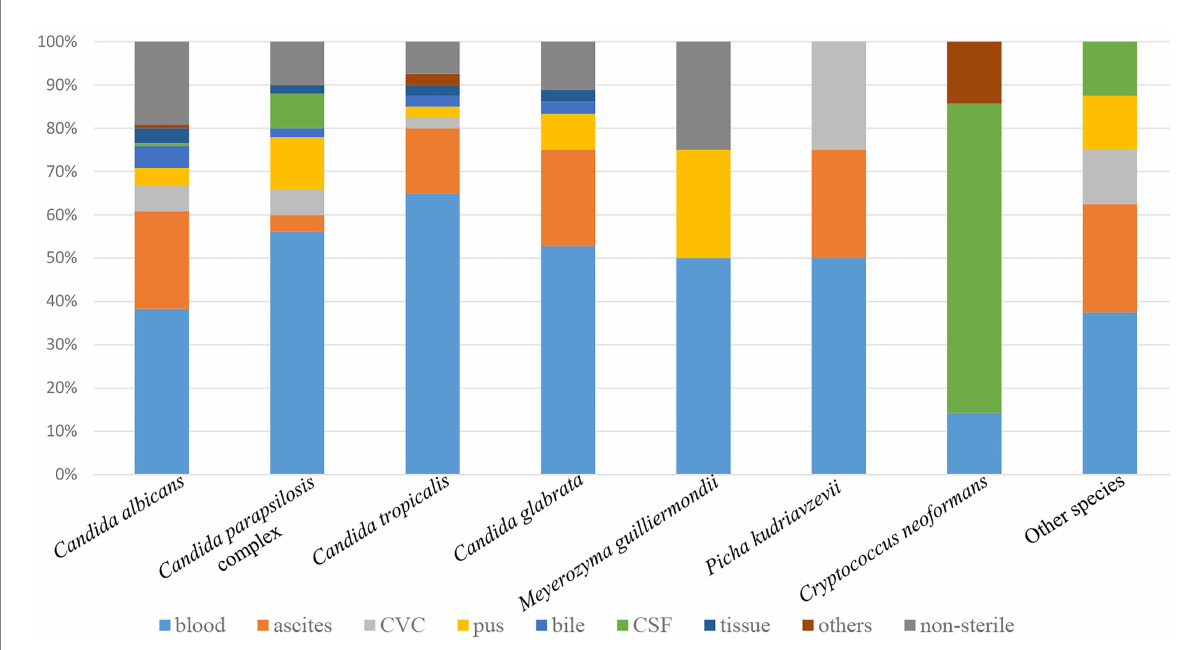
FIGURE 1 Distribution of yeast species by specimen type. Other species include 2 each of Clavispora lusitaniae , Trichosporon asahii , and Wickerhamomyces anomalus , 1 each of Cyberlindnera fabianii and Rhodotorula mucilaginosa . Other sterile sites include bone marrow and bronchoalveolar lavage fluid (BALF). Non-sterile samples include urine, feces, sputum, and genital tract secretion. CVC, central venous catheter; CSF, cerebrospinal